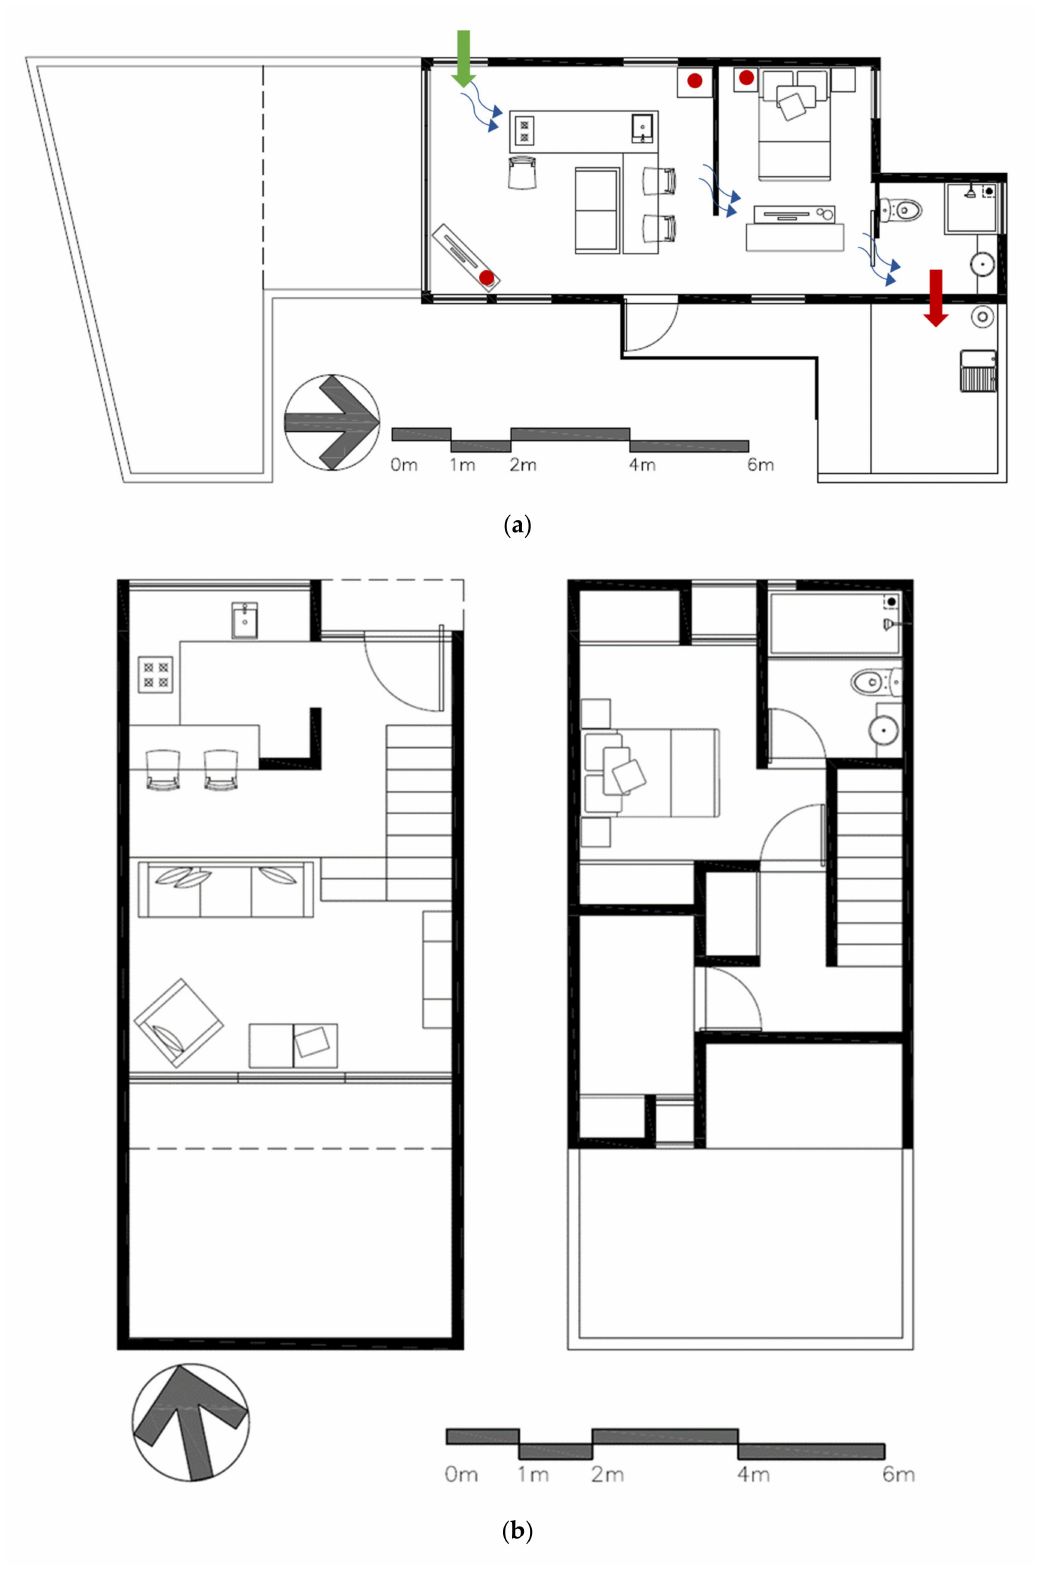
Figure 2. ( a ) Passivhaus dwelling floor plan. The red dots indicate the placement of the sensors. The blue arrows indicate the ventilation flow. The green and red arrows represent the inlet openings and extraction fan, respectively. Source: authors. ( b ) Standard dwelling floor plan. Source: